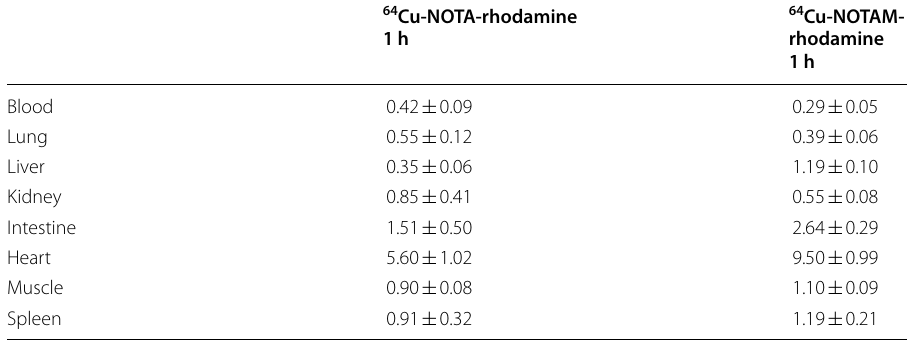
The values are average of % injected dose/gram